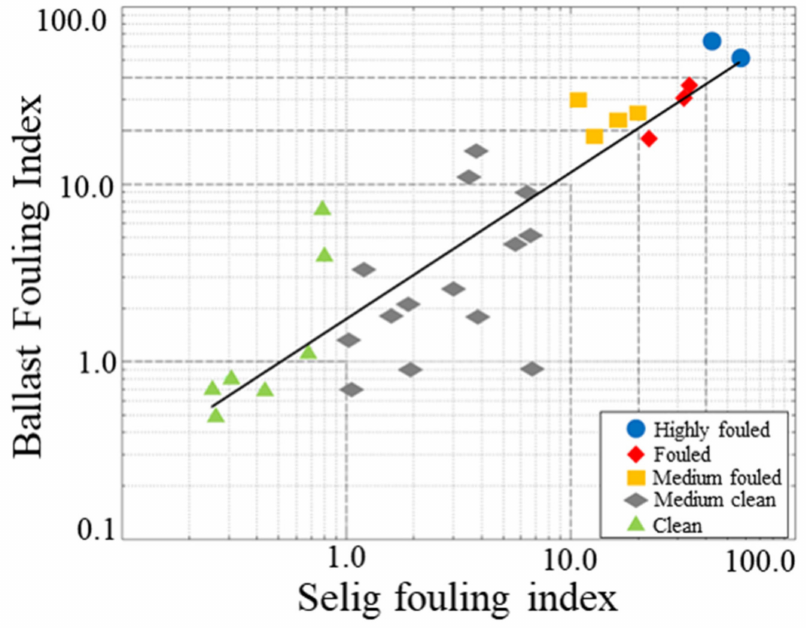
Figure 2. Relationship between sample Selig fouling index and BFI